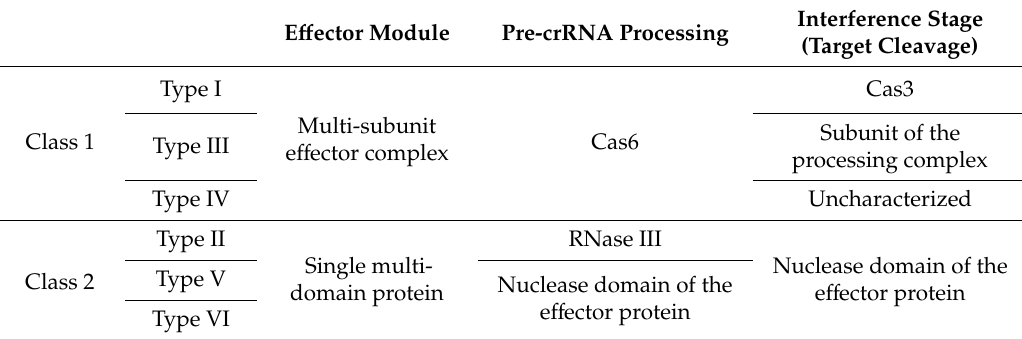
Table 1. The classification of CRISPR / Cas